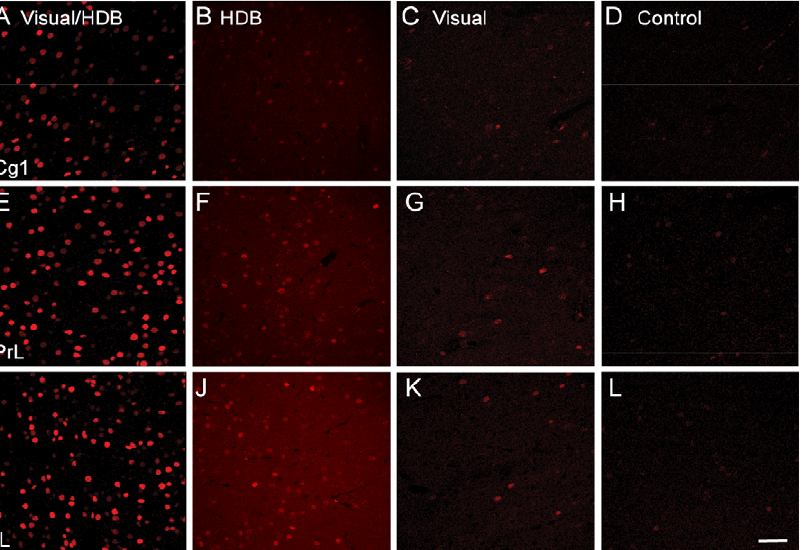
Figure 1. c-Fos immunoreactivity in layer V of the mPFC. Representative examples of c-Fos activity in layer V of Cg1 (A–C), PrL (D–F), and IL (G–I) in visual/HDB stimulated (A,D,G), visual stimulated (B,E,H) and control (C,F,I) rats. c-Fos + cells appeared as red cores. In the visual/HDB stimulation group, there were significantly lower c-Fos + cells in Cg1 compared to PrL or IL. There was no significant difference in c-Fos activity between PrL and IL. In all the three subregions of mPFC there was significant enhancement of c-Fos activity in visual/HDB stimulation rats compared to control or visual stimulated rats. Abbreviations: Cg1: cingulate cortex; IL: infralimbic cortex; mPFC: medial prefrontal cortex; PrL: prelimbic cortex. Scale bar: 50 m